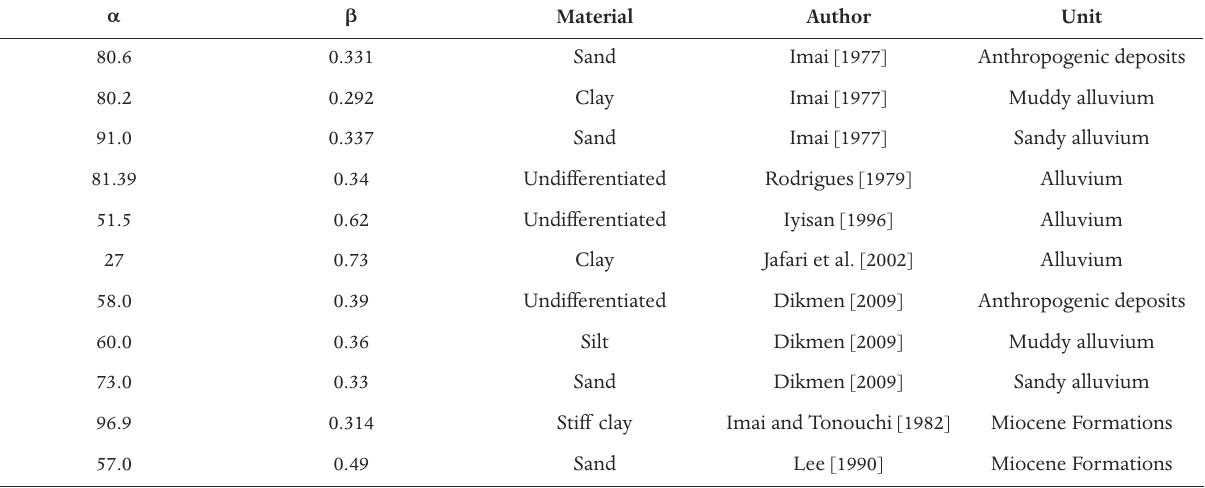
Table 4. a and b values proposed by several authors for different types of soils and stratigraphical contexts.